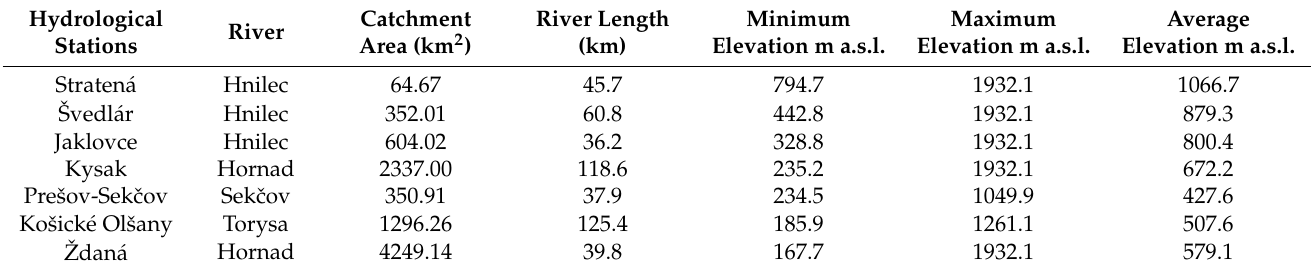
Figure 1. Hornad River catchment. Table 1. Values of selected physiographic characteristics of the Hornad River catchment.